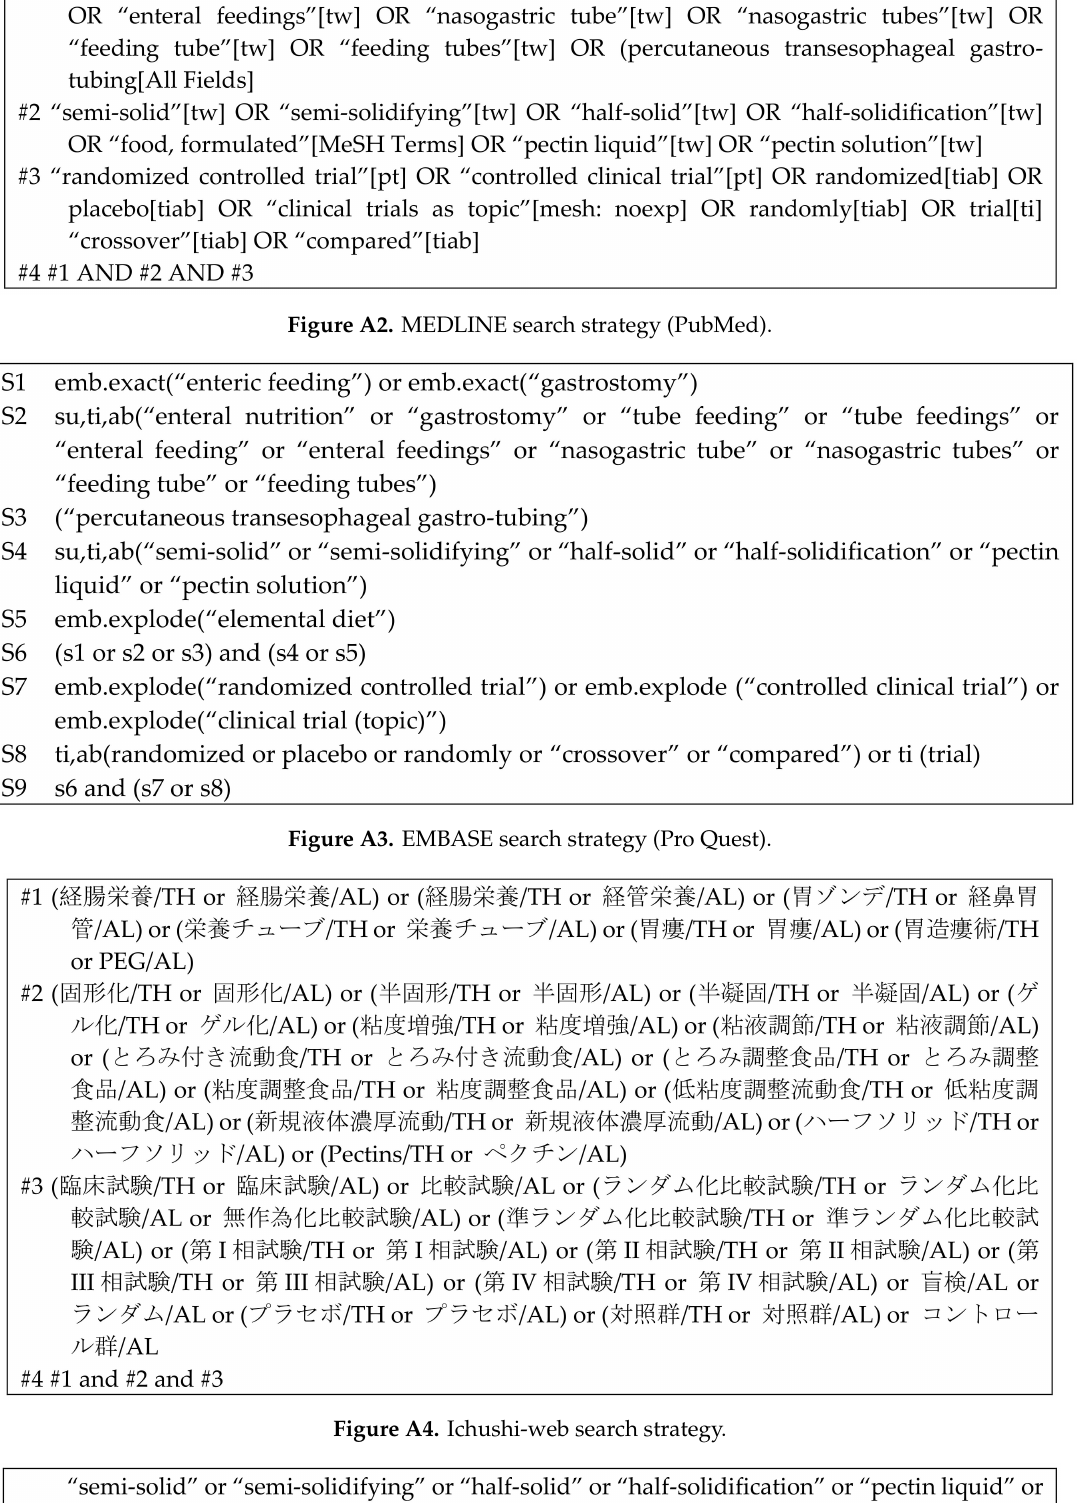
Figure A5. WHO-ICTRP search